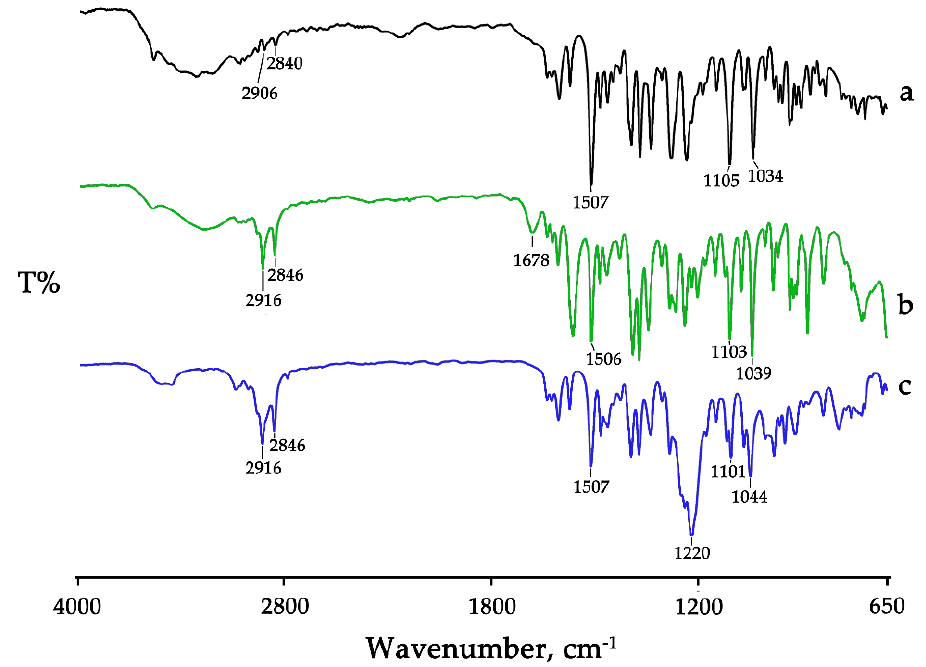
Figure 1. FT-IR spectra of the commercial product BBR-HCl ( a ); the salt obtained with NaLAU, BBR-L ( b ); and the salt obtained with SDS, BBR-S ( c ). Spectra are collected in transmittance reported on the Y axis versus wavenumber (in cm − 1 ) reported on the X-axis. In the commercial BBR-HCl (Figure 1, spectrum a), the band at 2906 and 2840 cm − 1 was related to CH 2 stretching vibrations, at 1507 cm − 1 to the vibration of the aromatic C-C, at 1105 cm − 1 to ring deformation and CH in-plane bending, and at 1034 cm − 1 to C-H vibrations in the rings. BBR salt with NaLAU shows a similar FT-IR spectrum (Figure 1, spectrum b), with the two bands at 2916 and 2846 cm − 1 more intensive and shifted to a higher wavenumber compared to the commercial product. These shifts together with the presence of a newly defined band at 1678 cm − 1 , due to the vibration of the asymmetric stretching of the COO- of lauric acid (shifted to lower wavenumber compared to that of the acid as such (Figure S1, spectrum a)), confirmed the isolation of BBR-L salt. Similar considerations can be extended to BBR-S salt (Figure 1, spectrum c), where the presence of the intense band around 1220 cm − 1 due to the sulfate group recorded at a higher wavenumber with respect to the vibration of the same group in the commercial SDS (Figure S1, spectrum b) sustained the effective salification process. As shown in Figure 2, the DSC curve of BBR-HCl (Figure 2A, curve a) exhibited two large endothermic effects in the temperature range between 40 and 160 ◦ C, which peaked at 91.8 ± 0.5 ◦ C and 140.1 ± 0.7 ◦ C, respectively. The first one revealed the hydrating nature of BBR-HCl, as confirmed also by TG analysis (Figure 2B, curve a’), where a mass loss of 4.1 ± 0.2% between 40 and 70 ◦ C was recorded, related to the dehydration of the active component, in agreement with the theoretical value corresponding to the loss of one molecule of water per molecule of BBR-HCl (4.8%). The second effect was related to a melting effect concomitant to a partial decomposition of the sample (loss of CO), as confirmed by the mass loss of 7.1 ± 0.2% between 65 and 100 ◦ C recorded in the TGA curve